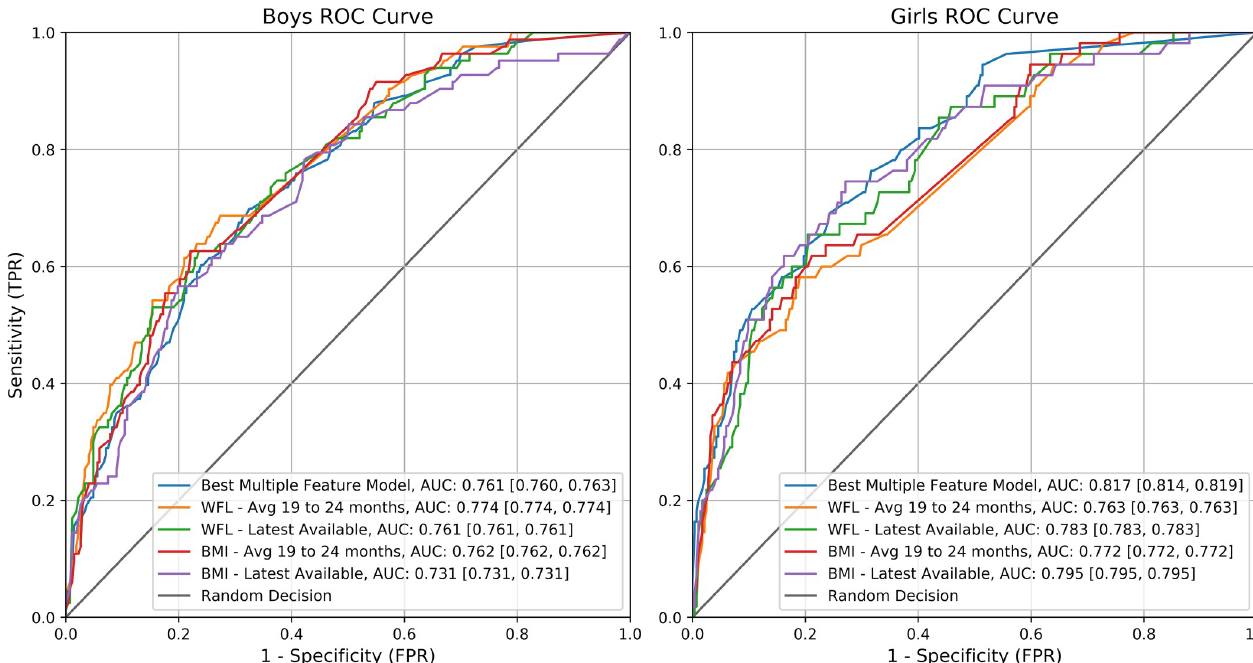
Fig 2. ROC curves for the top performing model compared to individual feature